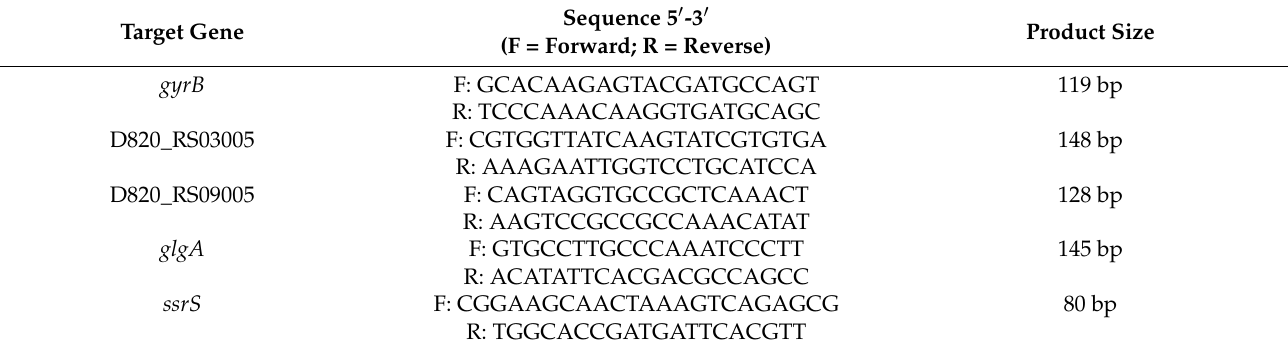
Table 1. Primer sequences for